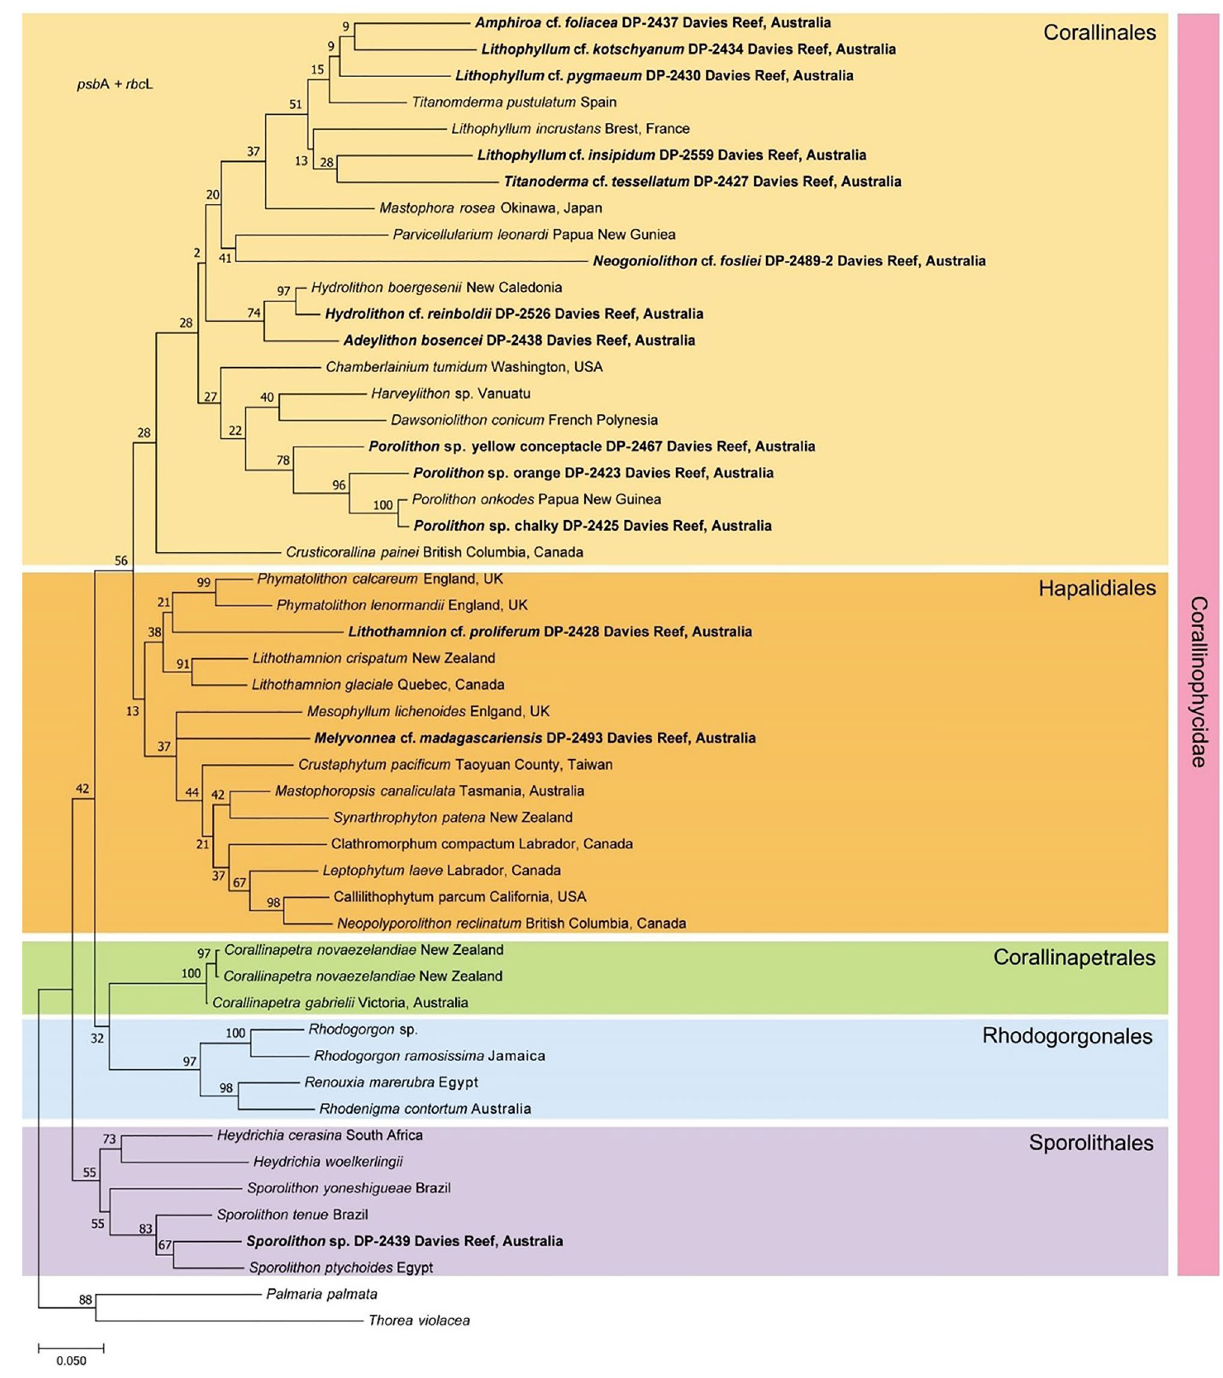
Figure 2. Phylogenetic tree based on Maximum Likelihood (ML) analysis of concatenated psb A and rbc L alignment. Values above branches denote maximum likelihood bootstrap values (BS) in %. Sequences obtained from this study are in